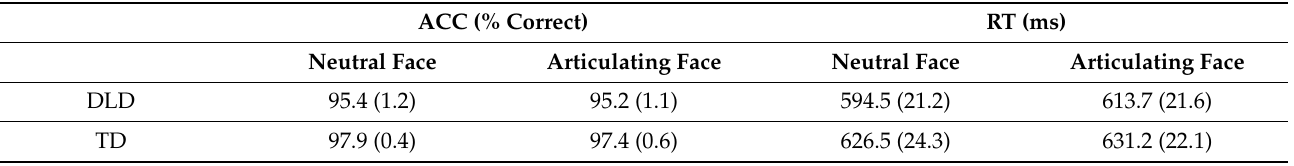
Table 3. Group means for accuracy (ACC) and response time (RT) while detecting silly facial expressions.